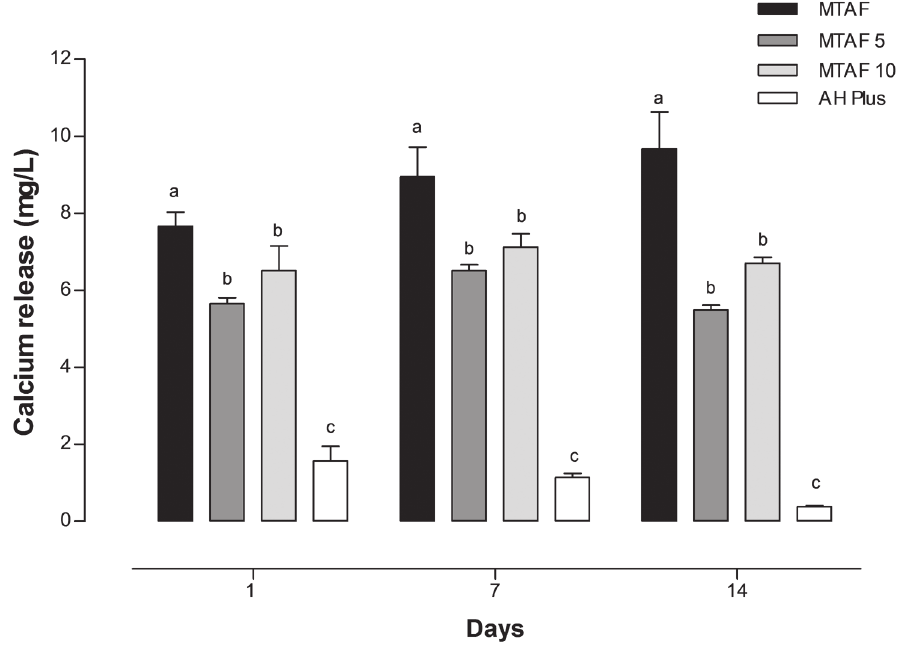
Figure 3- Calcium release (mg/L) from each sealer studied in the different experimental periods. Different letters indicate statistically significant differences